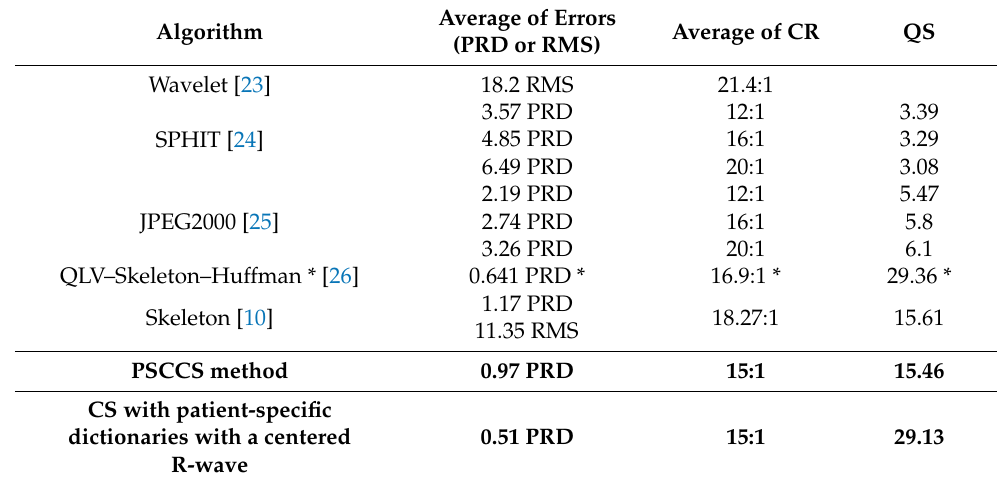
Table 11. Quality score for compression algorithms for average values for 24 records.